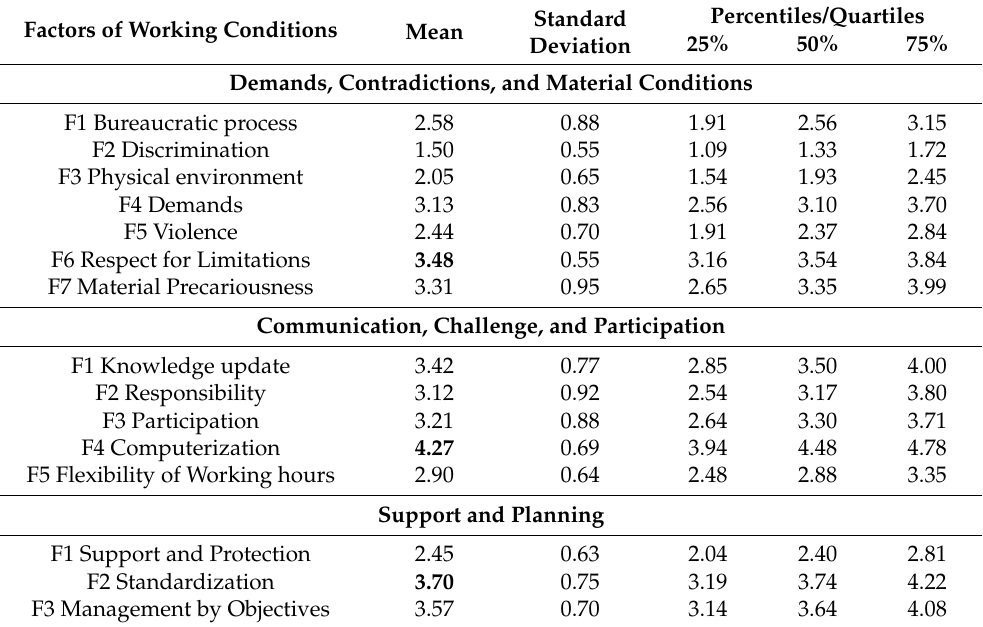
Table 1. Distribution of scores in the working condition factors ( n = 285). Factors of Working